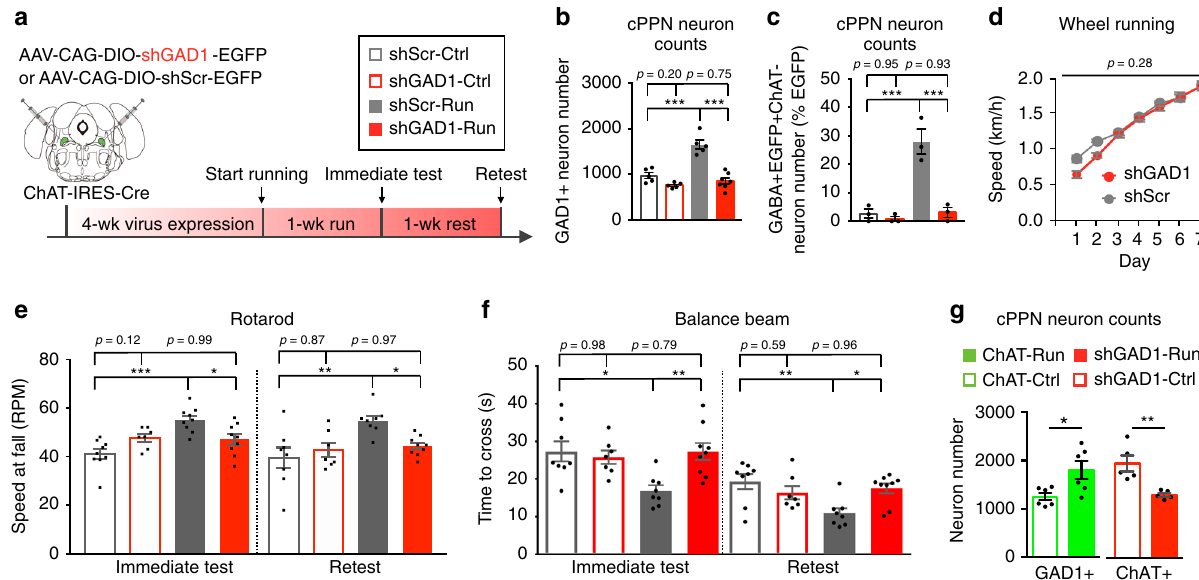
Fig. 7 Gain of GAD1 in cholinergic cPPN neurons is also necessary for running-enhanced motor skill learning. a Experimental design to override the gain of GAD1 in ChAT-Cre neurons and examine behavioral relevance. The coronal brain section was drawn according to the Franklin and Paxinos brain atlas 57 . b Numbers of GAD1 in situ stained neurons in the cPPNs of runners and non-running controls that were injected with AAV-DIO-shScr (scramble shRNA) or AAV-DIO-shGAD1 (shRNA for GAD1). n = 7 for shGAD1- Run, and fi ve animals for the other three groups. Nonparametric Kruskal – Wallis test followed by Dunn ’ s correction. c Percentage of neurons immunostained as GABA + , EGFP + and ChAT- in the total EGFP + neurons in cPPNs of ChAT-Cre runners and non-running controls that were injected with AAV-DIO-shScr or AAV-DIO-shGAD1. n = 1243 cells for shScr-Ctrl, 1258 for shScr-Run, 957 for shGAD1- Ctrl, and 1226 for shGAD1-Run from three animals per group. Nonparametric Kruskal – Wallis test followed by Dunn ’ s correction. d Wheel running speed of ChAT-Cre mice that express AAV-DIO-shScr or AAV-DIO-shGAD1 in the cPPN. n = 8 animals per group. Two-sided Welch ’ s t -test. e , f Rotarod ( e ) and balance beam ( f , 4-mm rod) tests show that expression of shScr did not affect the enhancement of acquisition and maintenance of motor skills gained by running (shScr-Ctrl vs. shScr-Run) whereas knocking down GAD1 blocked the enhancement (shGAD1-Run vs. shScr-Run). Blockade was sustained after rest for 1 week. For e , animal numbers are 9 for shScr-Ctrl, 7 for shGAD1-Ctrl, 9 for shScr-Run and 9 for shGAD1-Run for immediate test and 8 for shScr- Ctrl, 7 for shGAD1-Ctrl, 8 for shScr-Run and 9 for shGAD1-Run for retest. For f , numbers of animals are 8 for shScr-Ctrl, 7 for shGAD1-Ctrl, 8 for shScr-Run, and 9 for shGAD1-Run for both immediate test and retest. g Numbers of GAD1 in situ stained neurons in the cPPN of 1-week runners and non-runner controls that express AAV-DIO-ChAT and numbers of ChAT immunostained neurons in 1-week runners and non-runner controls that express AAV-DIO- shGAD1. n = 6 animals per group for ChAT-Run and ChAT-Ctrl and 5 for shGAD1-Run and shGAD1-Ctrl. Mann – Whitney U test. * p < 0.05, ** p < 0.01, *** p < 0.001. Data shown are mean ± SEM.